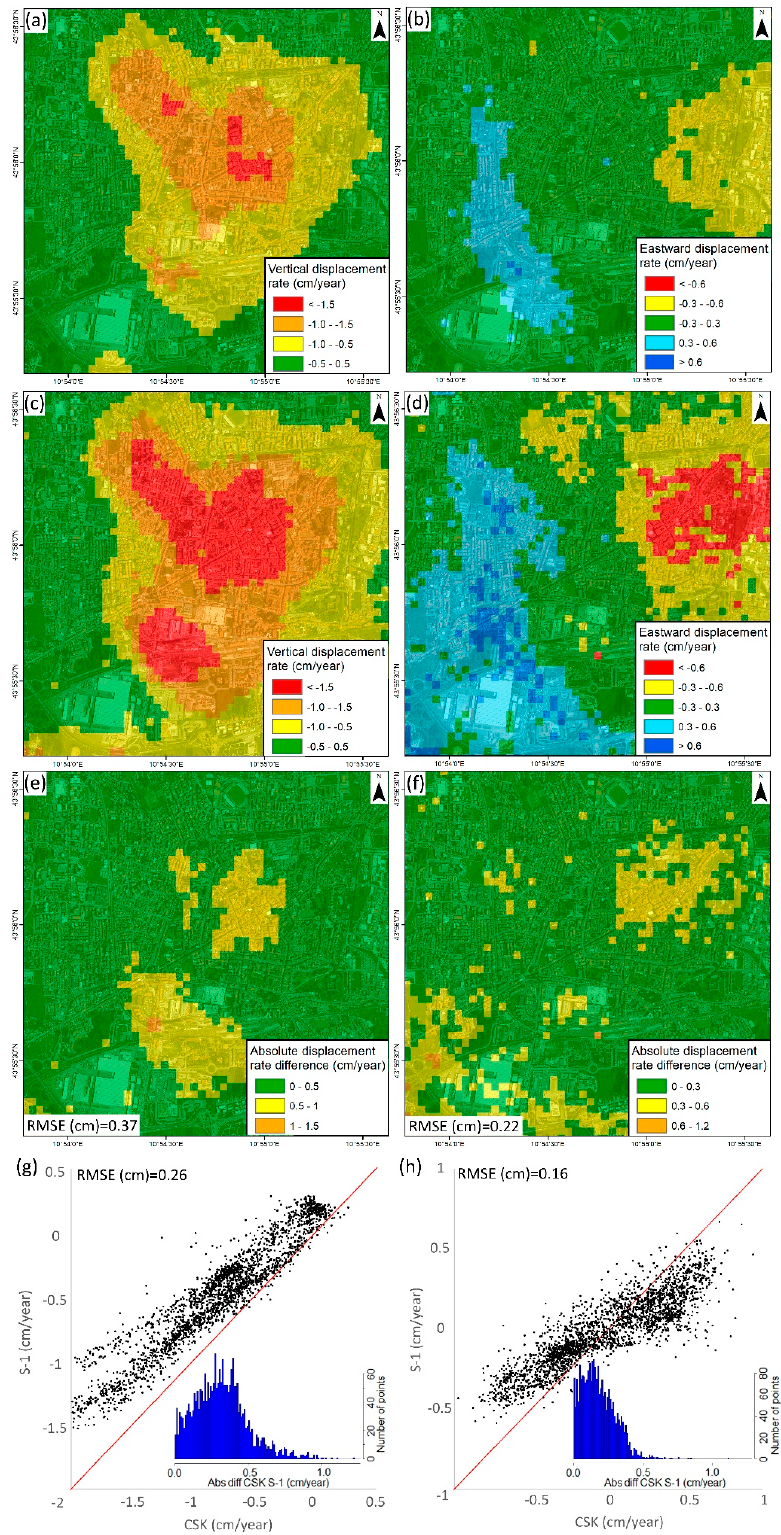
Figure 5. S-1 vertical ( a ) and EW ( b ) displacement velocities, CSK vertical ( c ) and EW ( d ) displacement velocities, and spatial comparison of vertical ( e ) and EW ( f ) results, and CSK-S-1 dispersion and histogram plots of vertical ( g ) and EW ( h ) geometries.